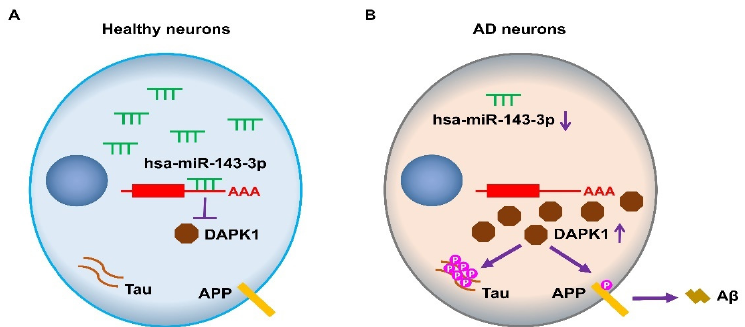
Figure 10. Schematic diagram showing the proposed roles of hsa-miR-143-3p in the regulation of tau phosphorylation and A β production through DAPK1 in AD. ( A ) In healthy neurons, hsa-miR-143-3p reduces the expression of DAPK1 by directly binding to its mRNA 3 ′ UTR, which results in inhibition of tau phosphorylation and A β production. ( B ) In AD neurons, the hsa-miR-143-3p levels are downregulated, and DAPK1 expression is upregulated, resulting in increased tau phosphorylation, APP phosphorylation, and A β secretion.